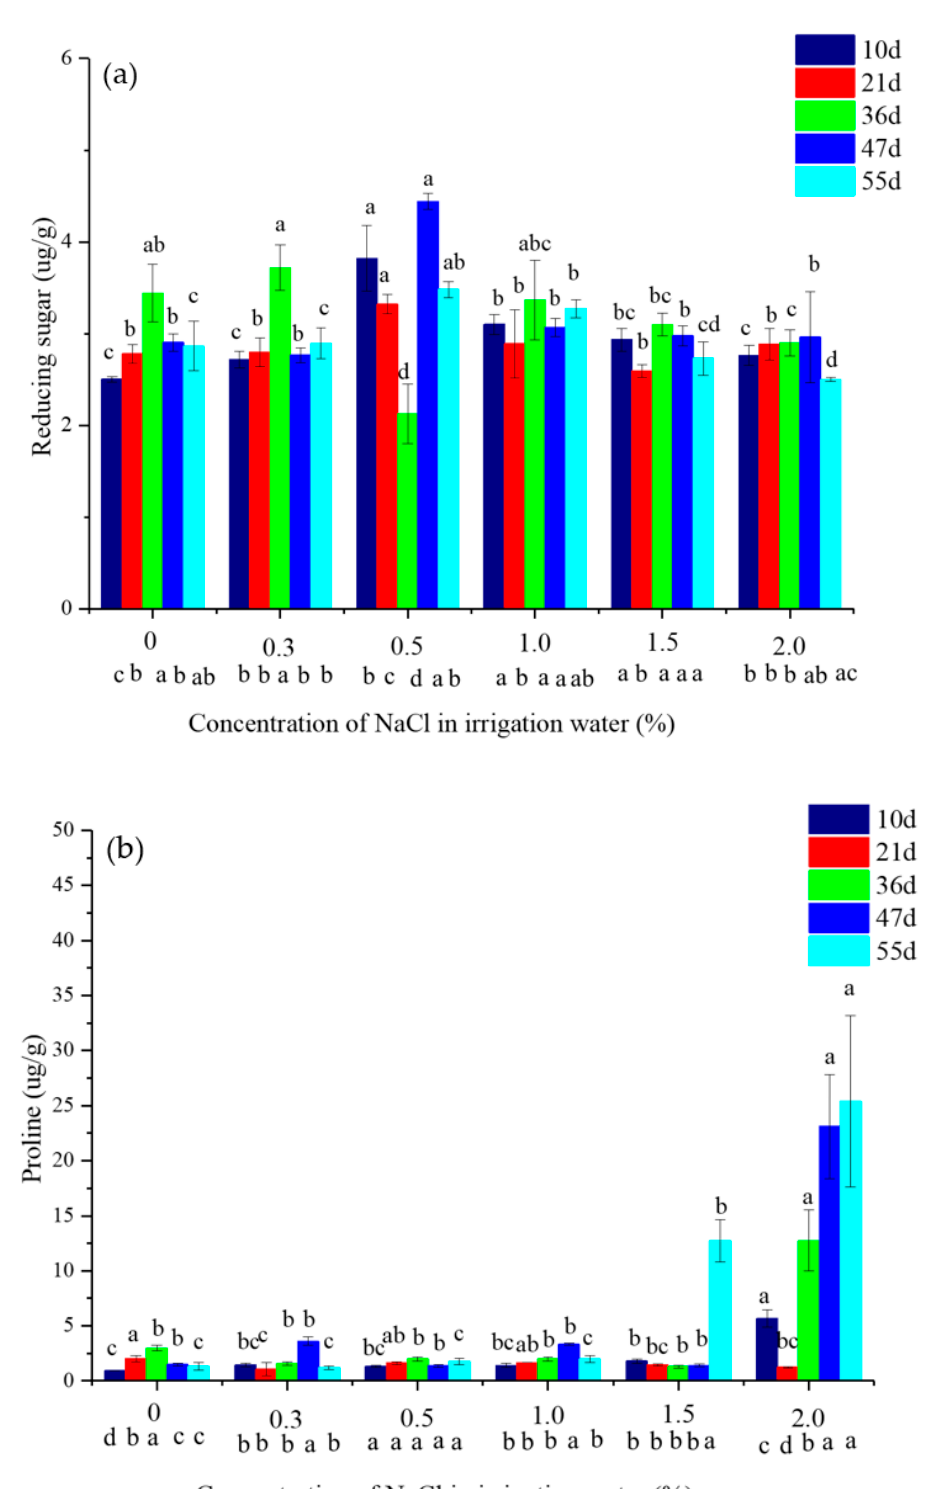
Figure 3. Reducing sugar ( a ) and proline ( b ) content in vetiver shoots at varying water salinities. Letters above the bars indicate the significance of different salinities at the same time of growth ( p < 0.05). Letters below the x -axis indicate the significance of different growth times at the same salinity ( p < 0.05). The data are shown as the mean ± standard deviation.